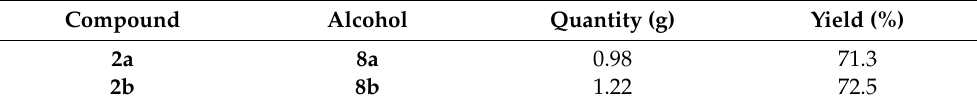
Table 5. Quantities of reagents used for the synthesis of 2a and 2b and